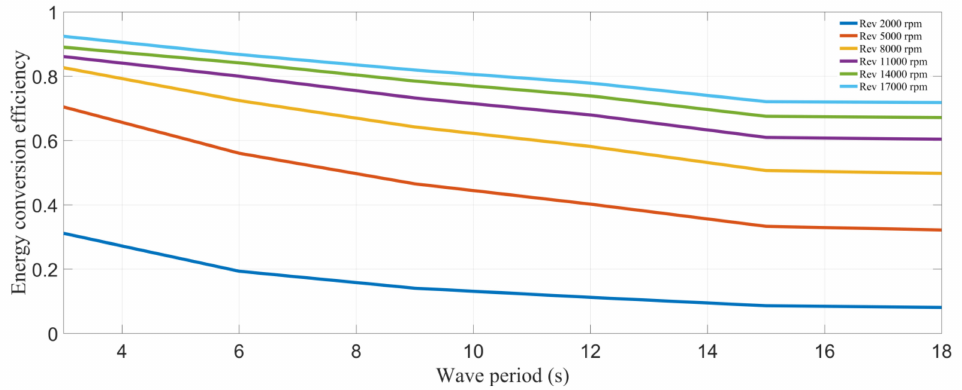
Figure 13. The influence of wave period.